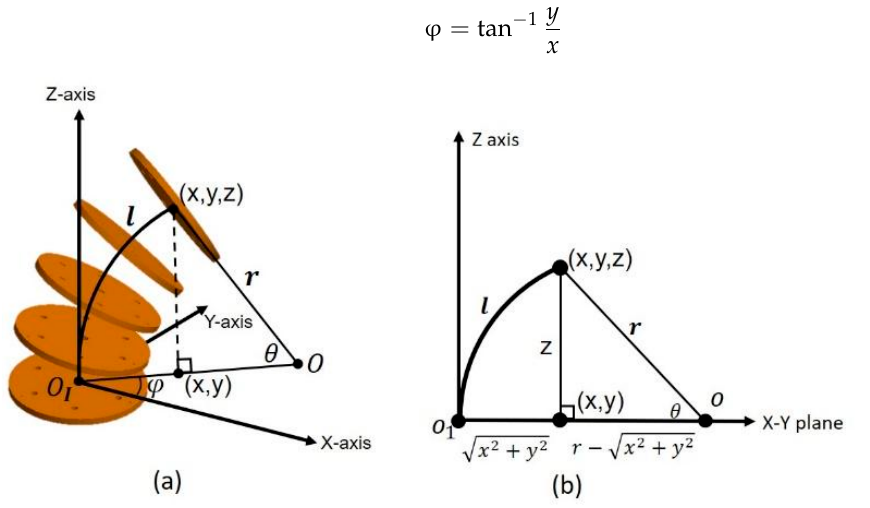
Figure 5. The posture of a single CKM reaching the target point: ( a ) three-dimensional and ( b ) two-dimensional.